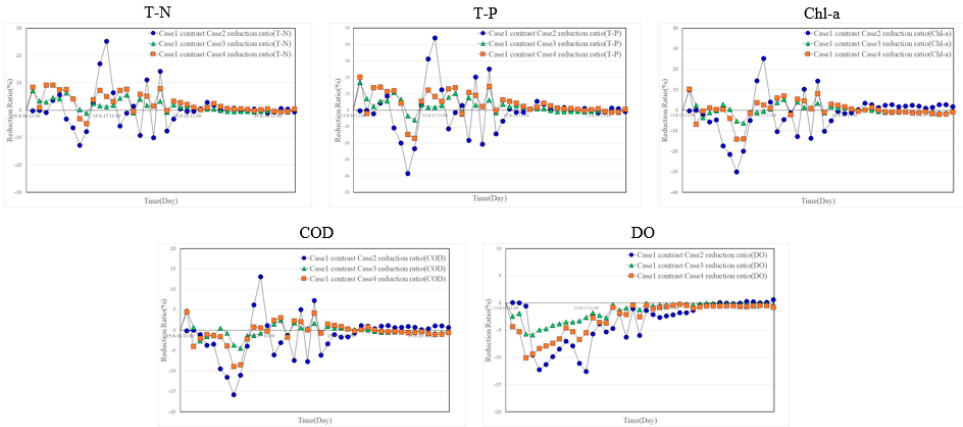
Figure 8. Case 1 Contrast Scenario Reduction Ratio.